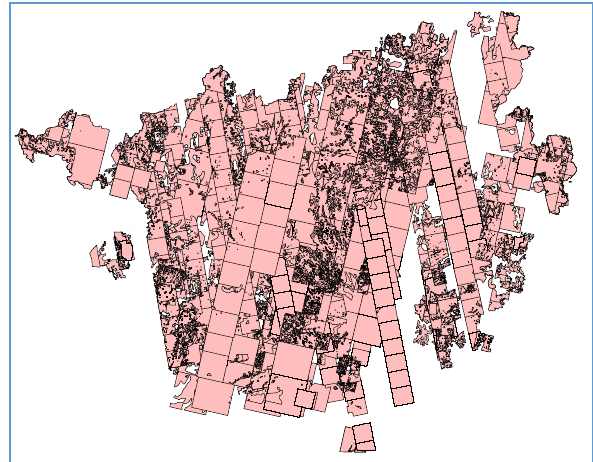
Figure 4. Store images of year 2018, month 7-12